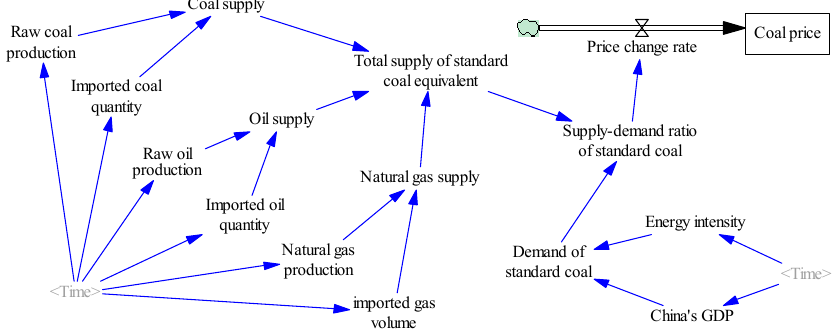
Figure 5. System flow diagram of coal price.